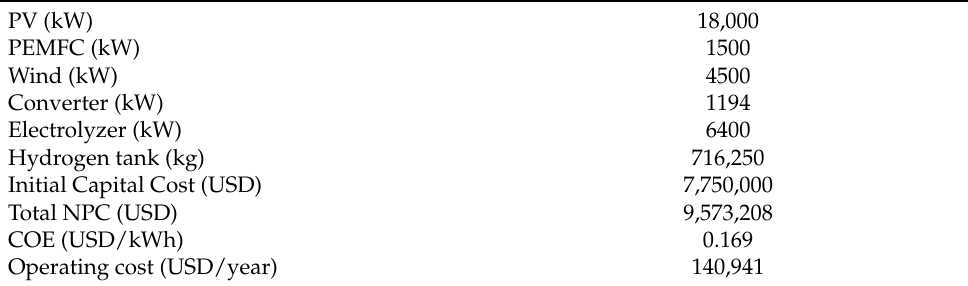
Table 5. The hybrid PV/FC/wind model’s optimization